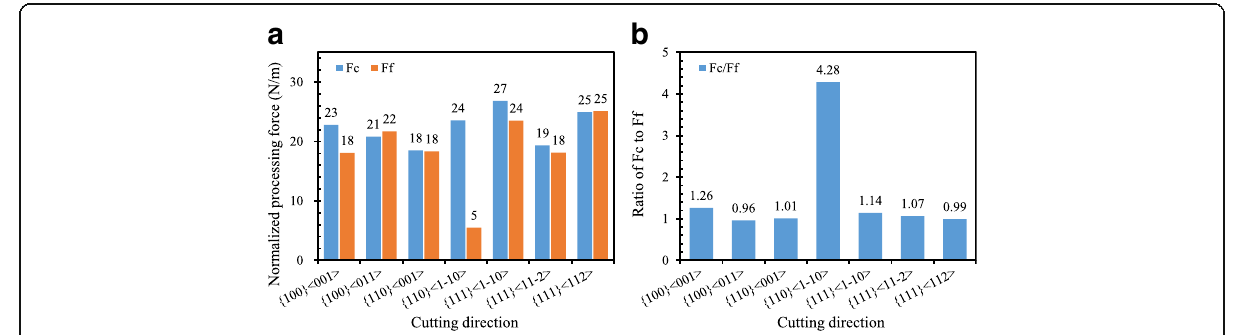
Fig. 10 a Average cutting force and feed force, b ratio of cutting force to feed force at different cutting